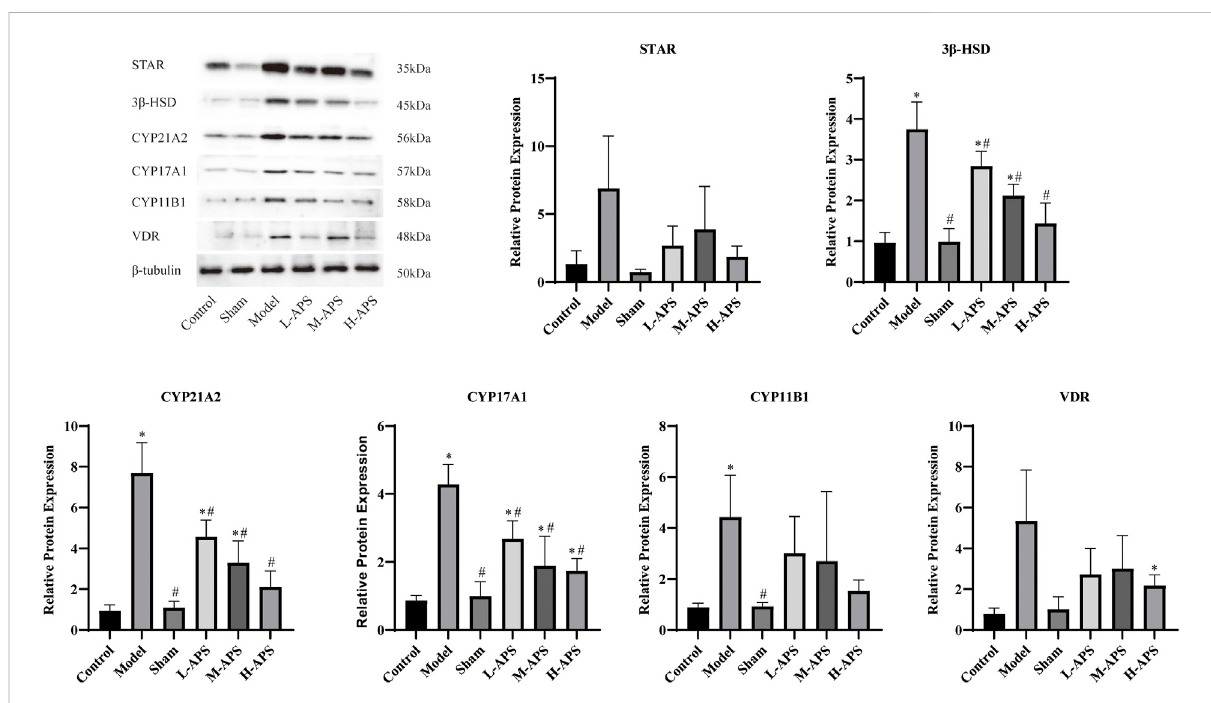
FIGURE 5 Western blotting assay detection of the effect of APS on the VDR protein surface in the adrenal cortex of septic rats. * p < 0.05 vs. control; # p < 0.05 vs. model.